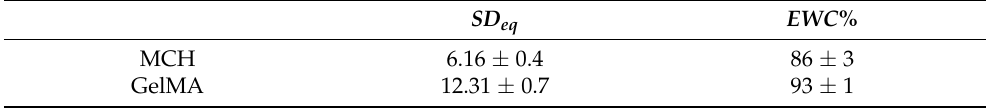
Figure 5. Swelling curves for UV-Cured MCH and GelMA hydrogels. In the insert is reported the swelling of GelMA UV-Cured hydrogels as an example. Table 1. Swelling properties of UV-Cured hydrogels.